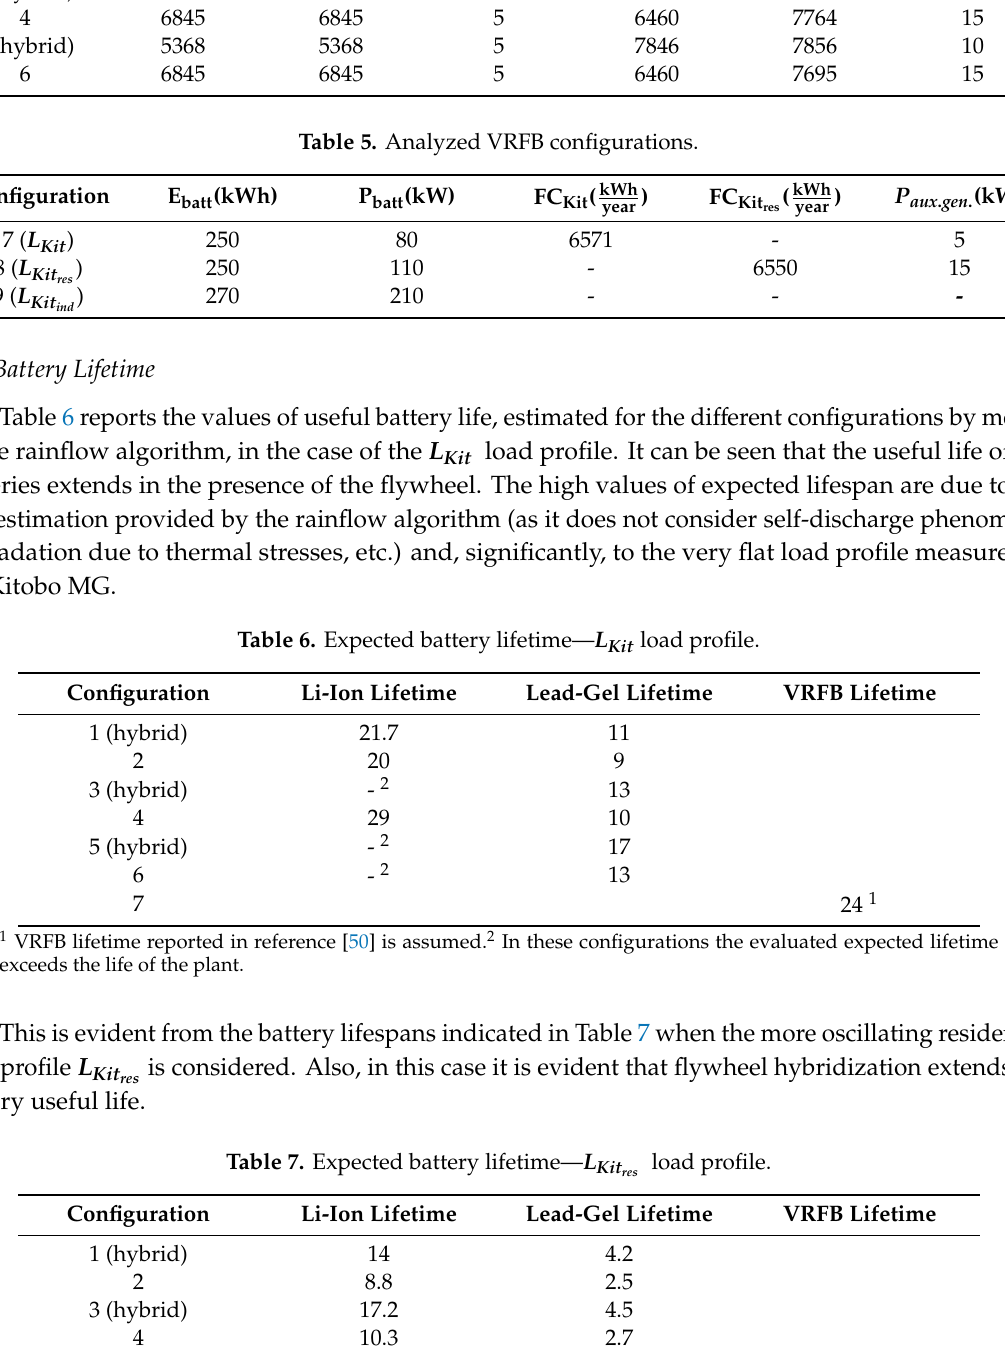
Table 7. Expected battery lifetime— L Kit